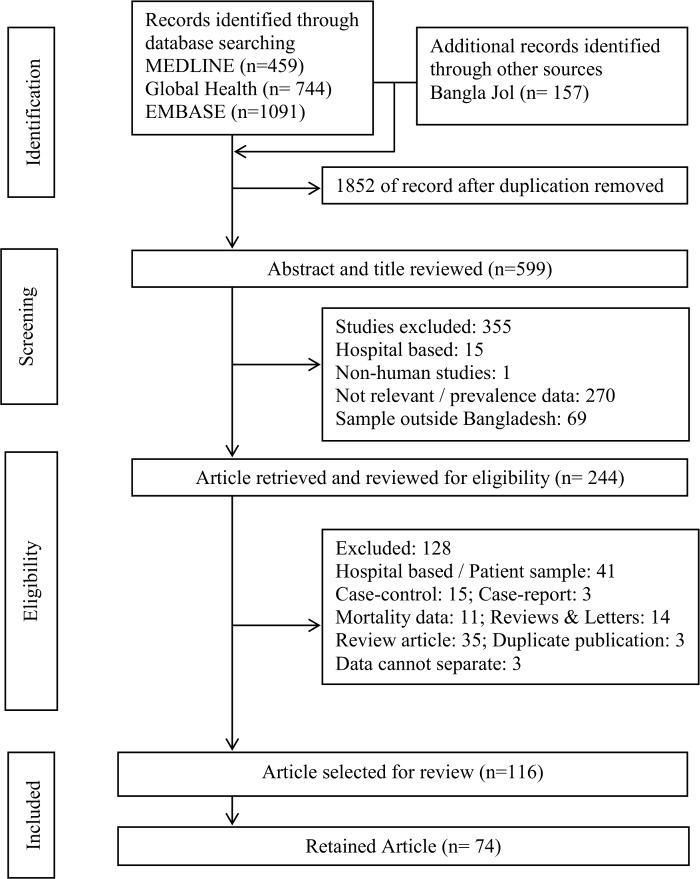
PRISMA diagram of the literature screening process.Numbers indicate the article count retained at each step of the process.